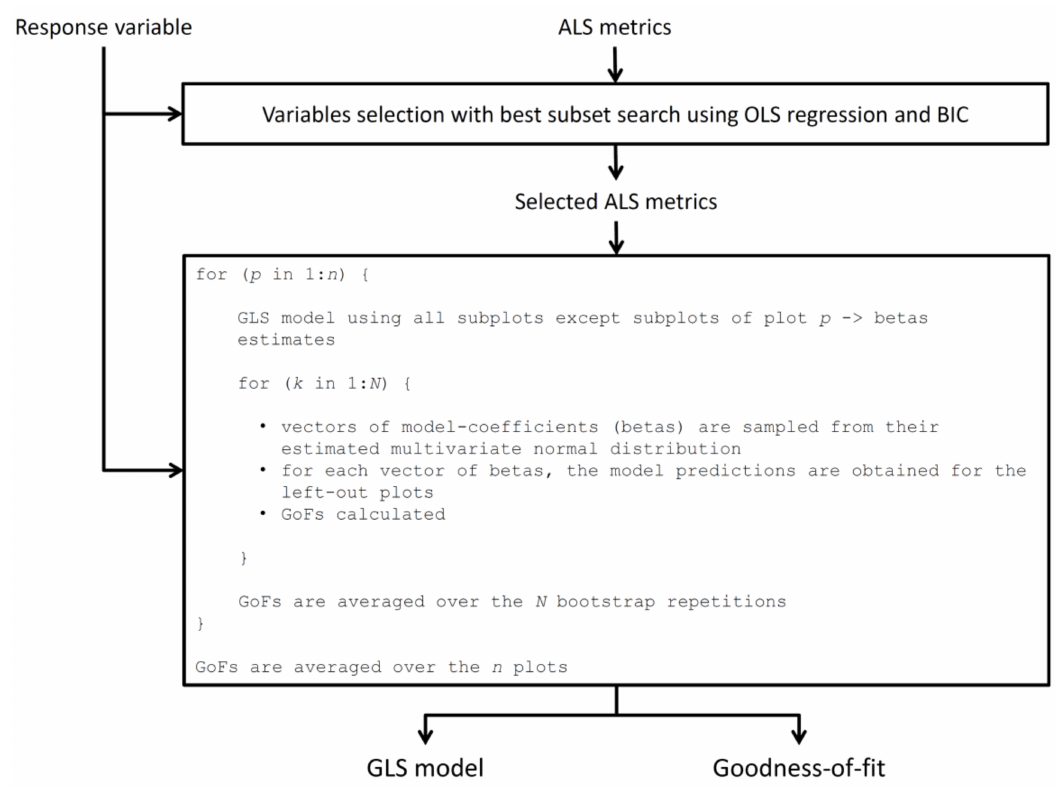
Figure 2. Architecture of the modelling